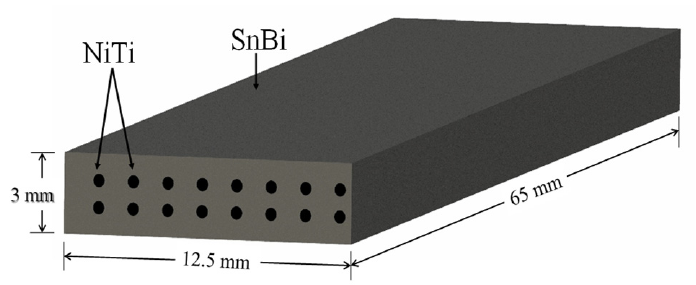
Figure 1. Sample Geometry.